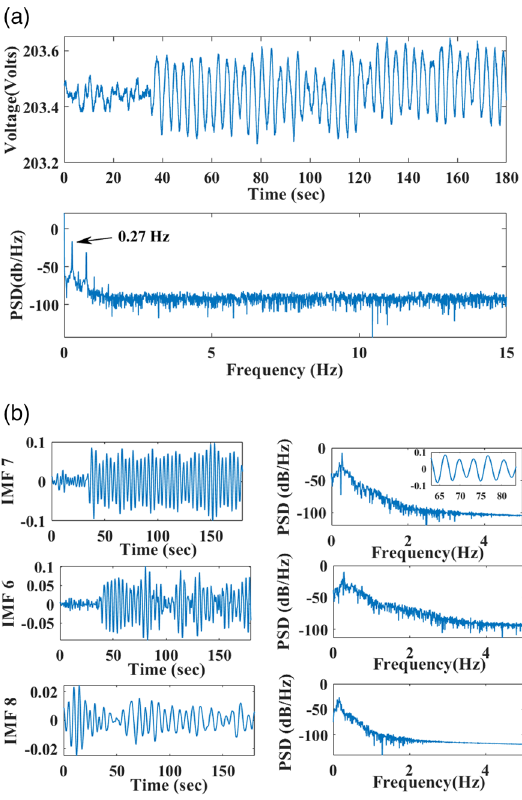
Fig. 10 a Actual raw PMU signal and its PSD at substation 4. b Decomposed modes of the raw PMU data